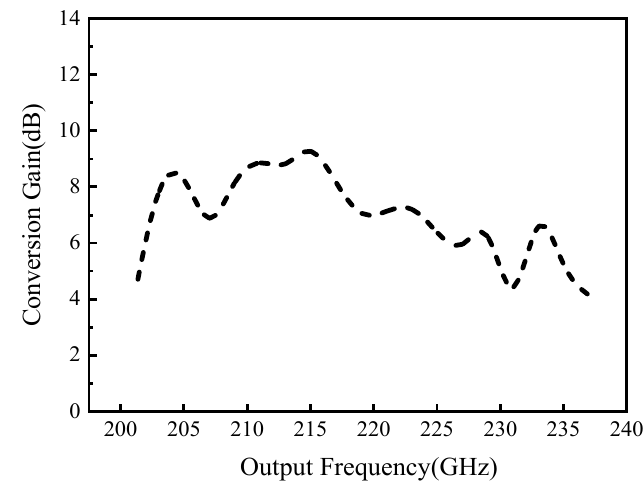
Figure 21. Output power of the 220 GHz transmitter.